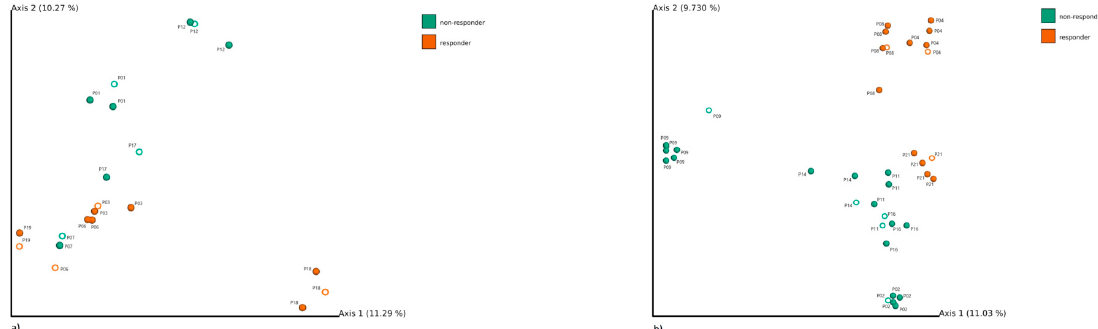
Figure 1. Principal coordinate analysis showing Jaccard’s distance matrix between responders (orange) and non-responders (green) for ( a ) aminosalicylates (5-ASA) group (8 patients) and ( b ) fecal microbiome transplantation (FMT) group (8 patients). Samples collected before therapy are shown as hollow spheres (8 samples per each 5-ASA and FMT group), samples collected after therapy initiation are shown as full spheres (13 samples for 5-ASA and 31 samples for FMT group); samples belonging to one patient are described with the same number.